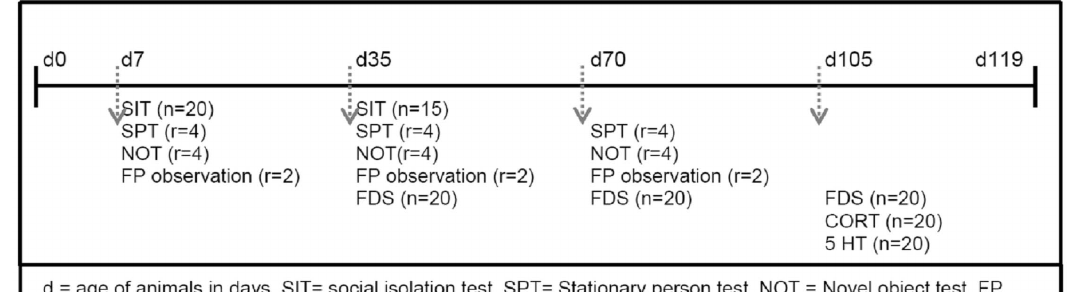
Figure 1. Time line of age of birds in days (d) with tests executed at specific ages.